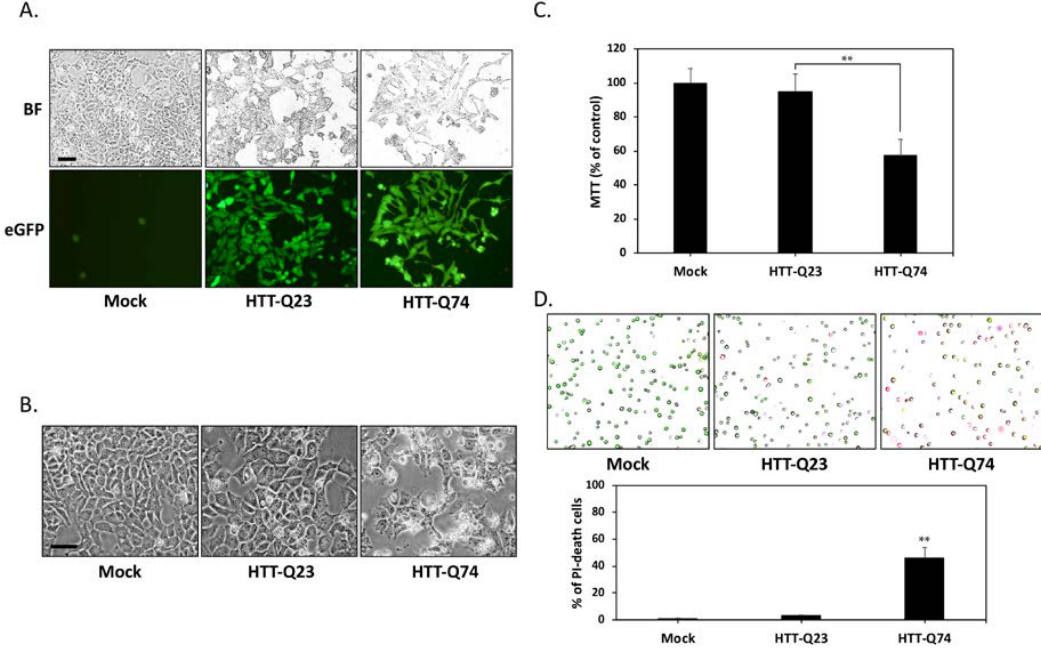
Figure 1. Q74-mHTT overexpression induces the apoptosis of human neuronal SK-N-MC cells. ( A ) SK-N-MC cells were transfected for 24 h with the empty vector (mock), normal polyQ HTT (pEGFP-Q23 HTT), or polyQ-expanded mHTT (pEGFP-Q74 HTT). The presence of green fluorescent reporter eGFP signals indicated the successful delivery and expression of HTT-Q23 or HTT-Q74 plasmids. BF, bright field. Scale bar represents 20 μm; ( B ) Phase-contrast microscopy images of cells taken after 48 h of transfection. In contrast to HTT-Q23-overexpressing cells, mock-transduced cells did not show any morphological characteristics of cytotoxicity or cell death. However, cell death markedly increased among HTT-Q74-overexpressing cells. Scale bar represents 20 μm; ( C ) Colorimetric MTT assay results for cell proliferation indicated that after 48 h of transfection, cell death reached 43% in the HTT-Q74-overexpressing group relative to that in the mock- or normal HTT-transduced groups; ( D ) AO–PI double staining assay results obtained with an automated dual fluorescence cell counter. AO conferred green fluorescence to live cells (green circles), and PI conferred red fluorescence to dead cells (red circles). The numbers of apoptotic cells were quantified by averaging the cell counts of five independent samples. At least three independent experiments were performed, and values are presented as mean ± SEM. Significant difference was determined by using the multiple comparisons of Dunnett’s posthoc test for ** p < 0.01 compared with mock groups.